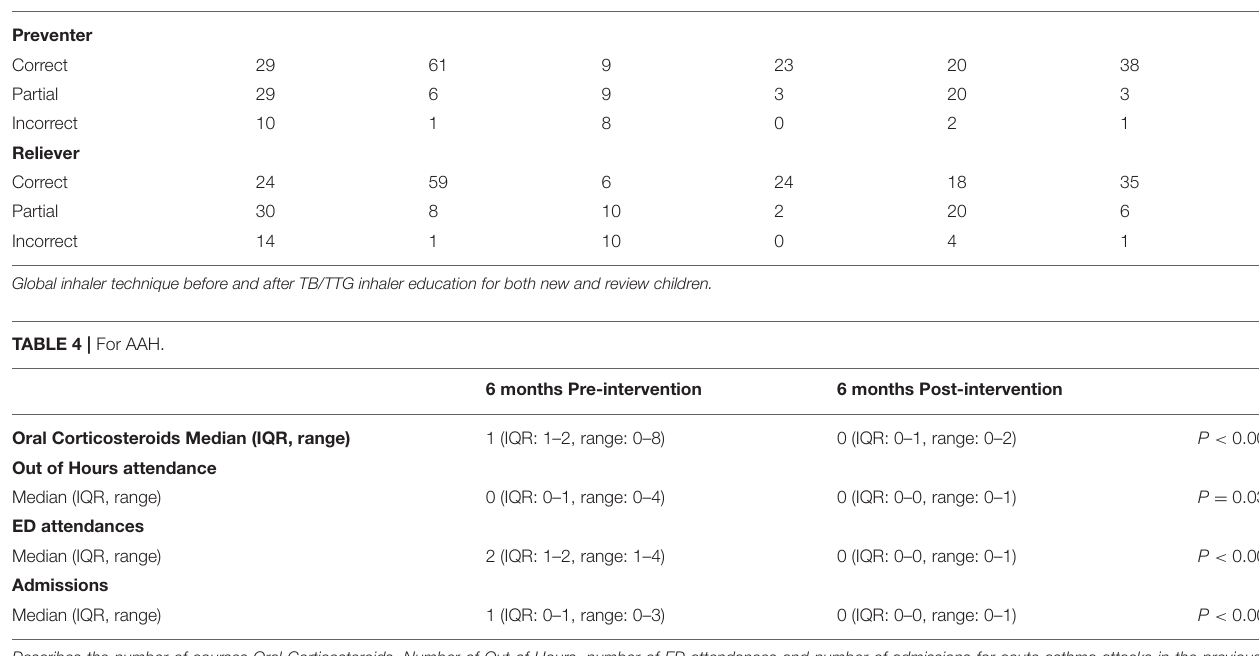
Total number (before training)